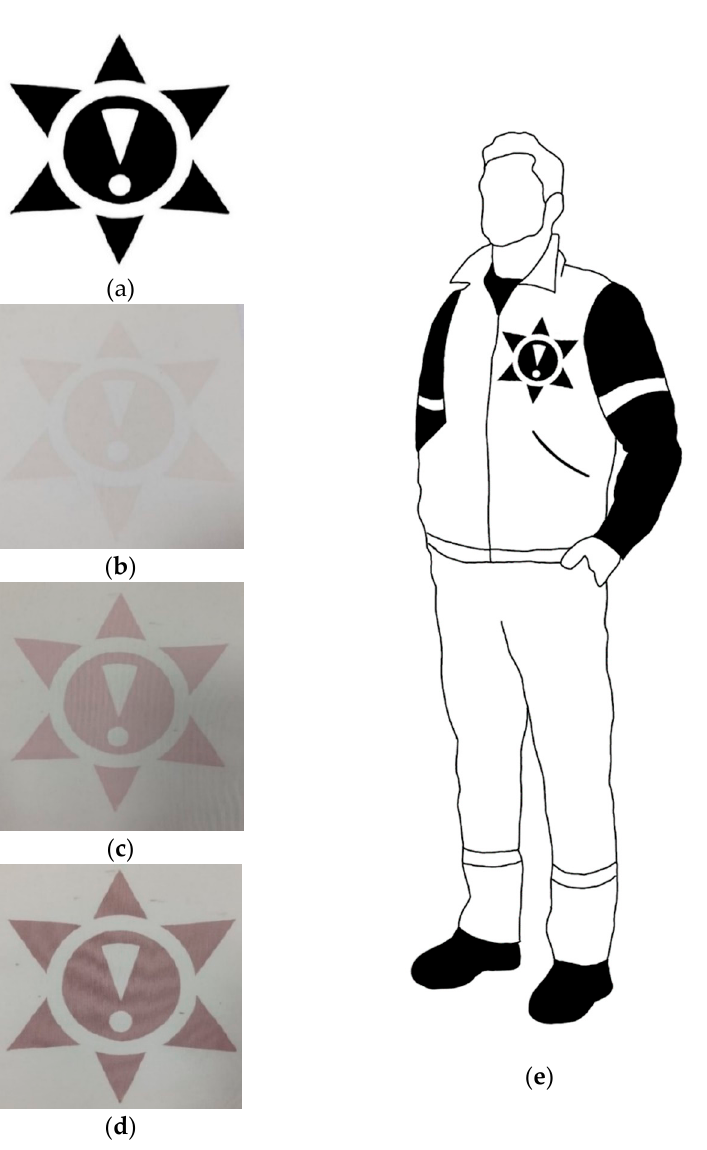
Figure 10. The pattern design ( a ); the pattern printed on cotton fabric with NBT-Pluronic F-127 hy- drogel containing 1 g/dm 3 NBT, non-irradiated ( b ) and irradiated with 0.05 J/cm² ( c ) and 0.7 J/cm² ( d ) of UVB radiation; an example of the location of the pattern on the protective clothing ( e ).